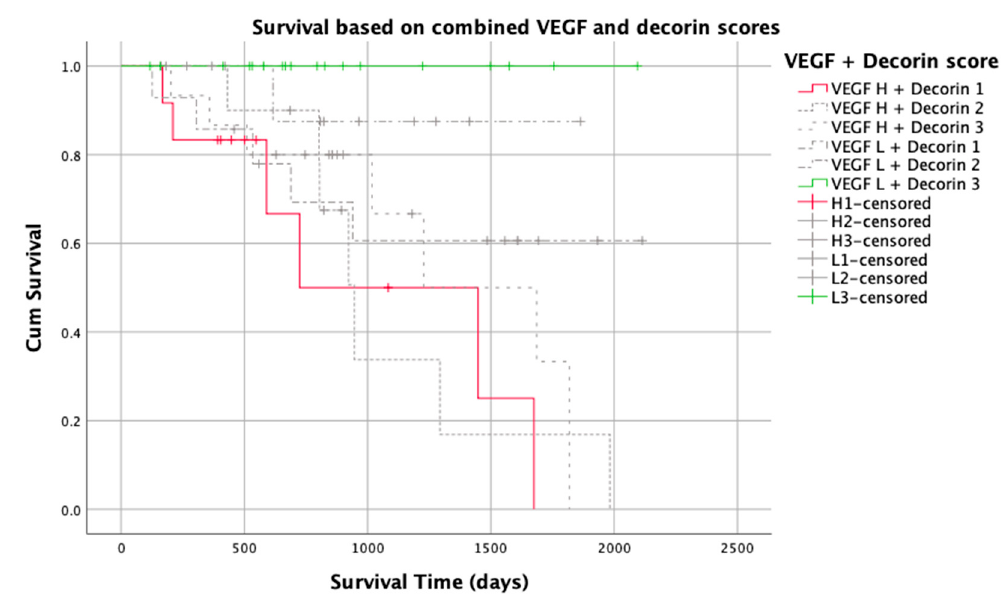
Figure 8. Kaplan–Meier graph of survival time for 73 patients with soft tissue sarcoma based on 6 groups of combined VEGF and decorin immunostaining levels. The extreme prognostic groups (H1 and L3) are highlighted; survival times between these two groups are signi fi cantly di ff erent (1031 days vs. 1924 days, p < 0.001). Table 4. Univariate cox-regression analysis for survival and local recurrence for patients based on VEGF, decorin and combined immunostaining groups.